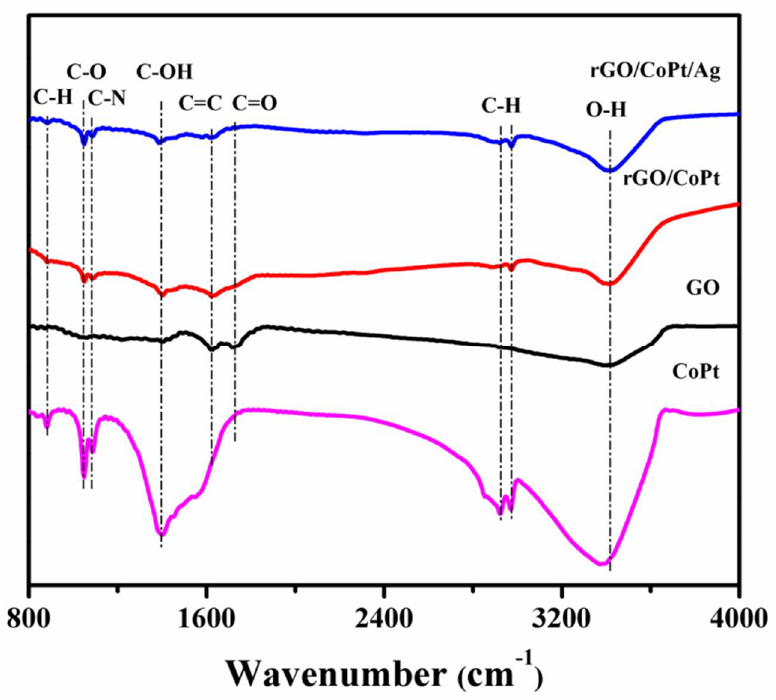
Figure 3. FT-IR spectra of CoPt, GO, rGO/CoPt, and rGO/CoPt/Ag.